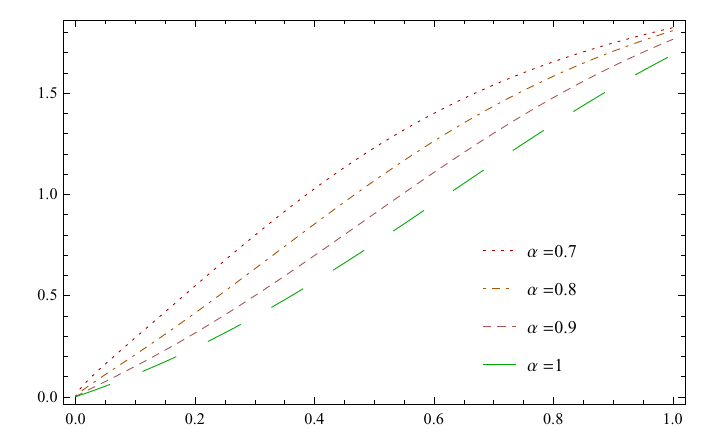
Figure 1. Comparison of f(t) for N = 1, M = 5, with q = 0 . 7 , 0 . 8 , 0 . 9 and exact solution